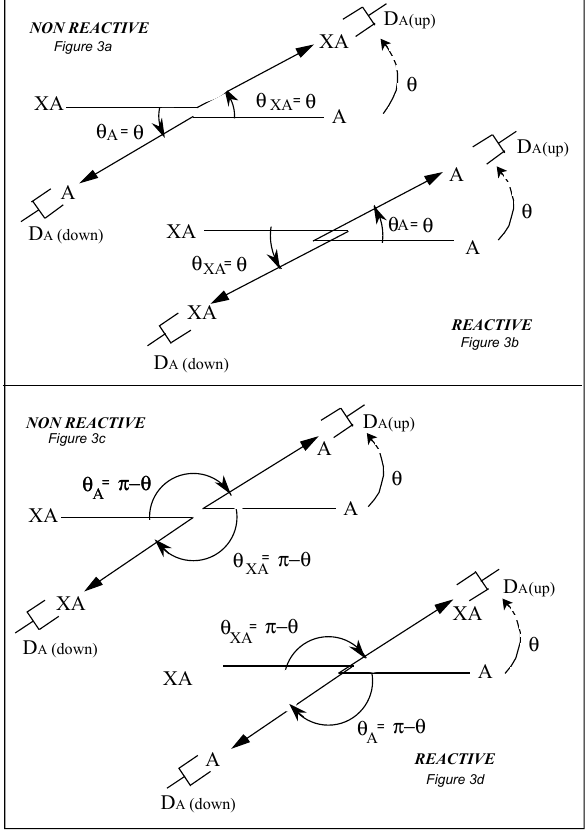
Fig. 3. Schematic diagram of the trajectory of different isotopic species as a function of their scattering angles in a cross beam ex- periment between XA and A. A and XA are detected by the upper and lower detectors D A . As for the reactions between XA and B, the differential scattering cross sections measured by the upper and lower detectors D A are strictly equal.